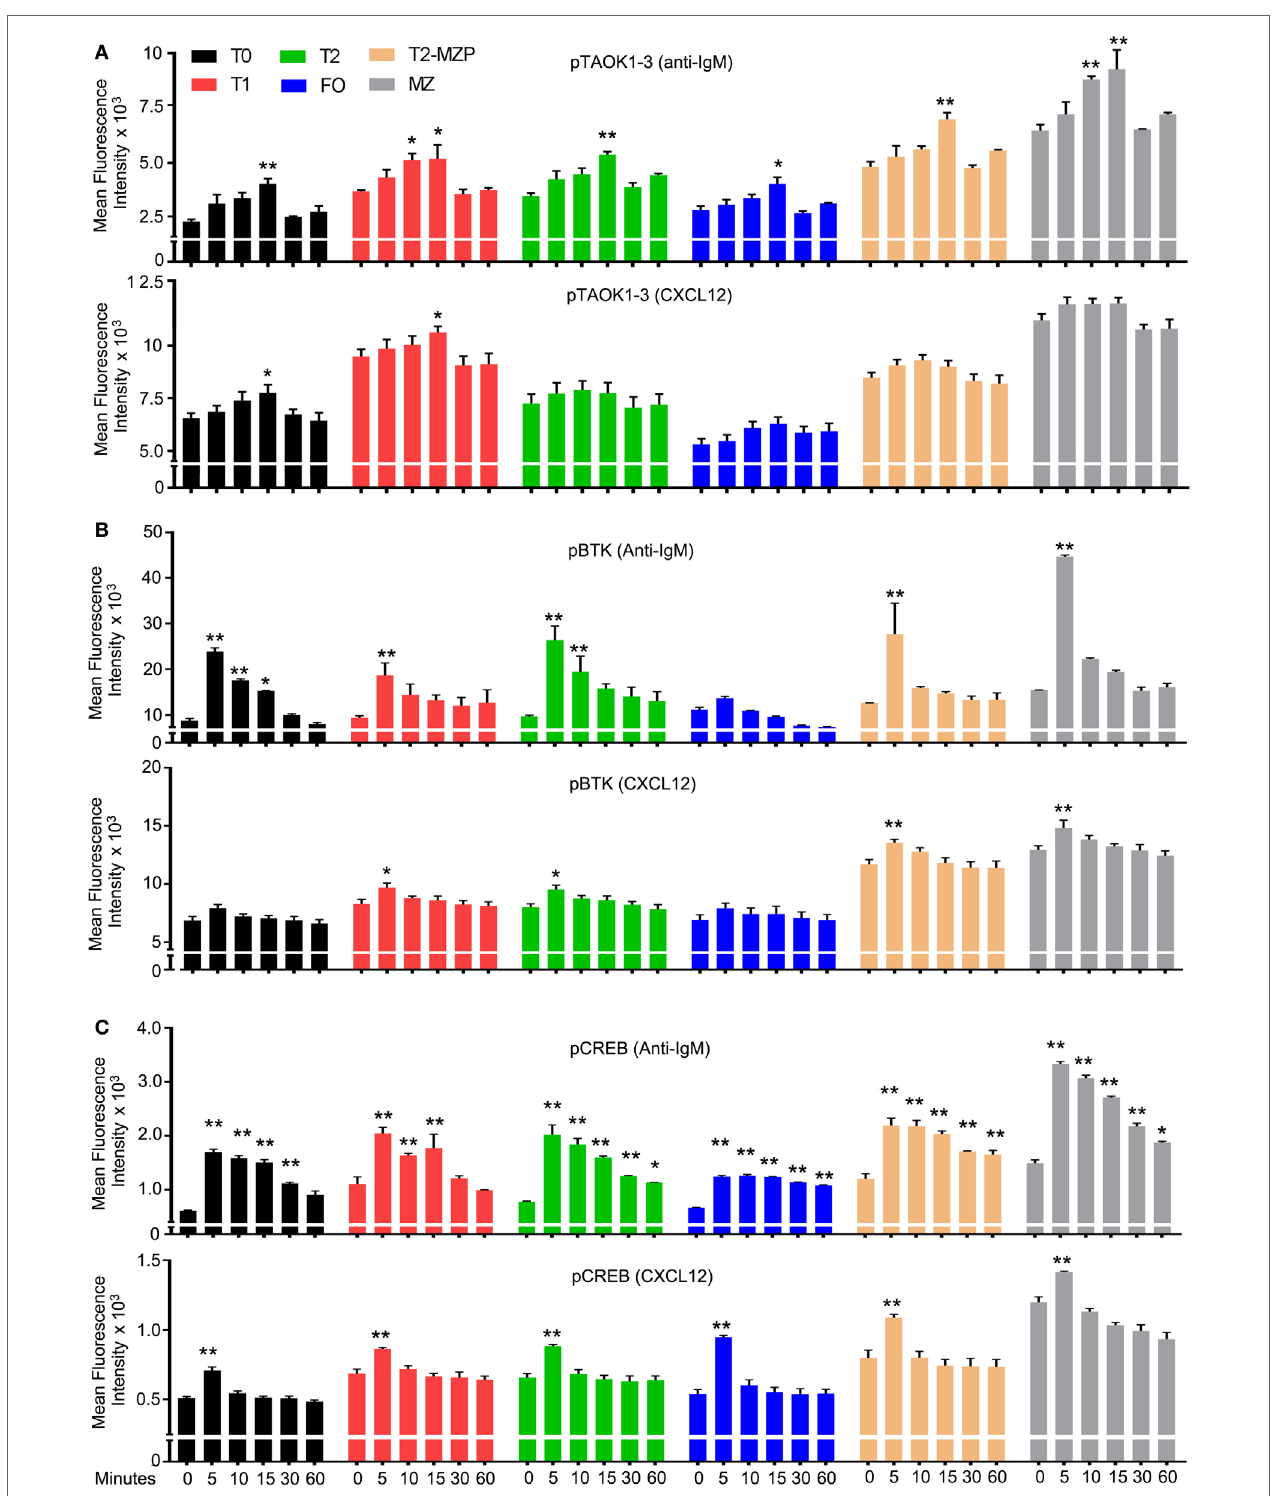
FigUre 5 | Both CXCL12 and anti-IgM raise the level of pTAOK, phosphorylated Bruton’s tyrosine kinase (pBTK), and pCREB in transitional B cells. (a–c) Intracellular FACS results from WT splenic B cells stimulated with either CXCL12 (1 µg/ml) or anti-IgM (10 µg/ml) for the indicated durations. Prior to addition of the stimulant, the B cells were incubated in media for 30 min. Following fixation and permeabilization, the cells were immunostained for expression of pTAOK (a) , pBTK (B) , or pCREB (c) . The results are from the analysis of splenic B cells from four mice (two versus two, performed twice). Data are mean ± SEM (* p < 0.05, ** p < 0.005).